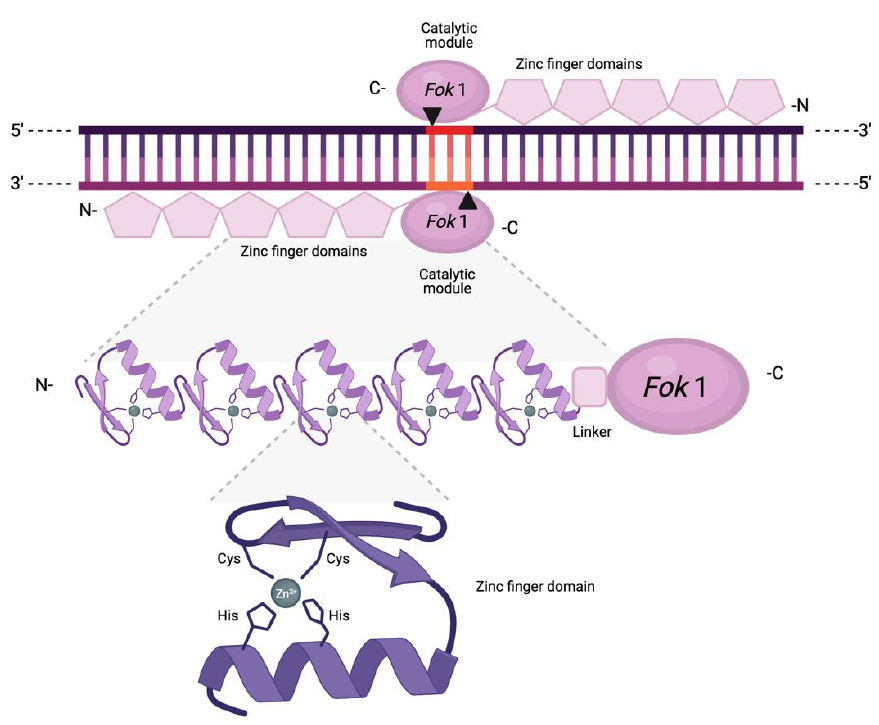
Figure 3. Schematic representation of a zinc finger nuclease pair with distinct binding (ZF motifs) and cleaving (FokI) domains. Each ZF motif comprises a conserved set of two cysteines (Cys) and two histidines (His), which interact directly with a central zinc ion. This interaction, along with the dual beta sheets and single alpha helix, result in the characteristic protruding structure. The arrows and the highlighted region represent the resulting DSB and 3-nt 5′ overhangs.